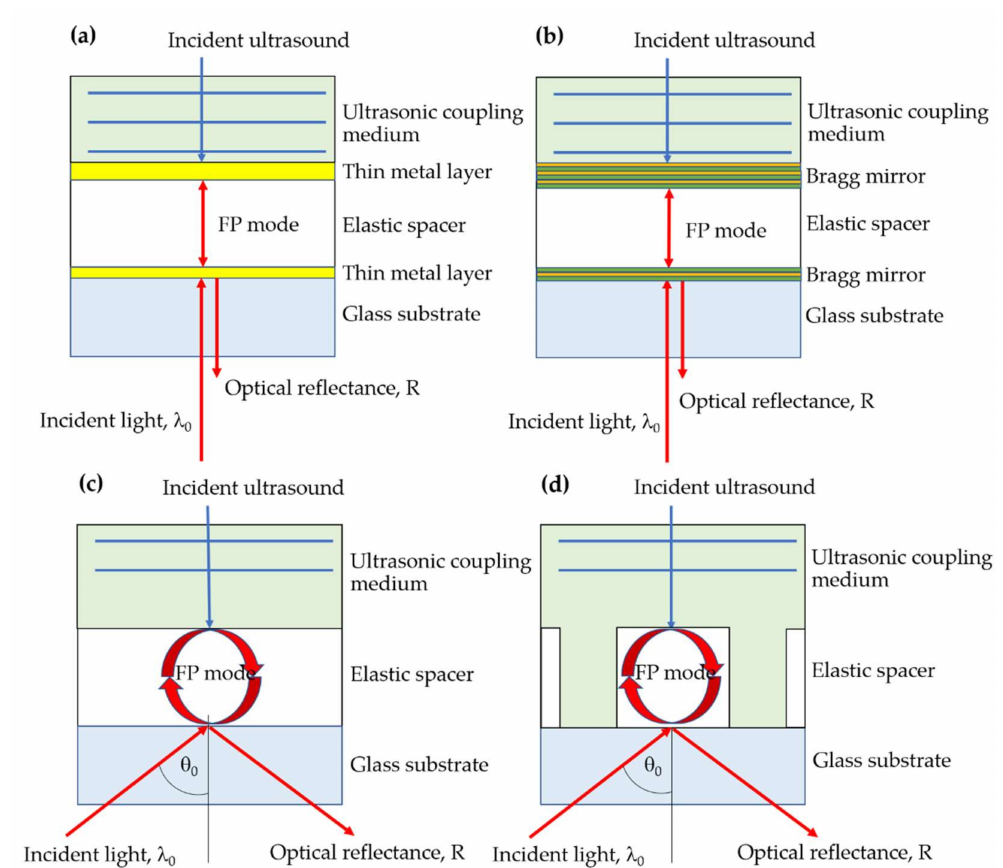
Figure 1. ( a ) Fabry–Perot (FP) mode in bimetallic mirrors, ( b ) FP mode in Bragg reflectors, ( c ) FP mode in uniform polydimethylsiloxane (PDMS), and ( d ) FP mode in PDMS